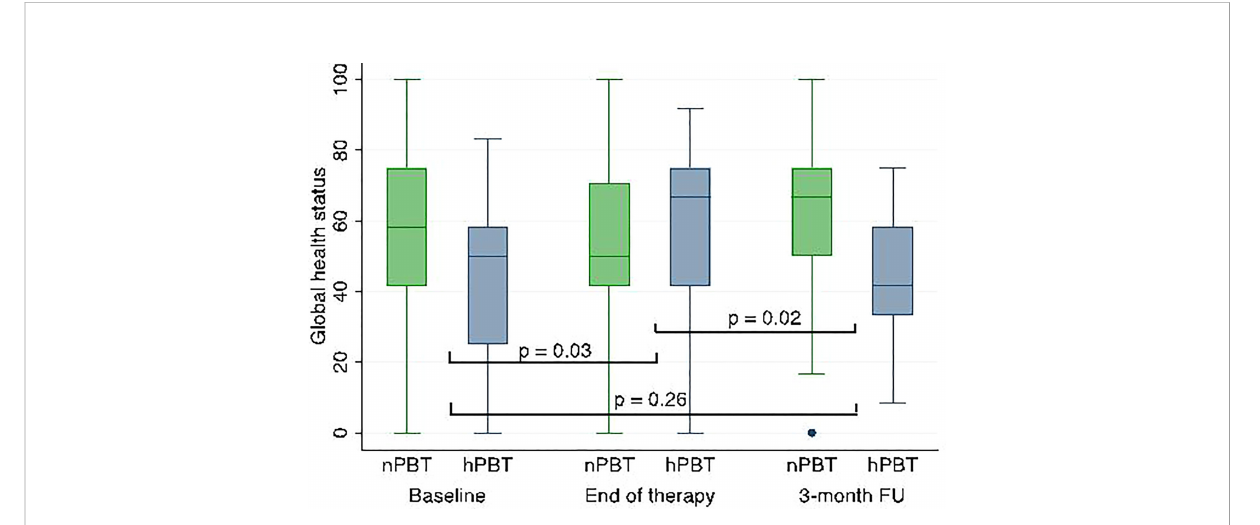
FIGURE 1 Global health status scores over time and according to fractionation groups in H&N patients; p-values refer to differences between nPBT and hPBT at corresponding time points. H&N, head and neck; nPBT, normofractionated proton beam therapy; hPBT, hypofractionated proton beam